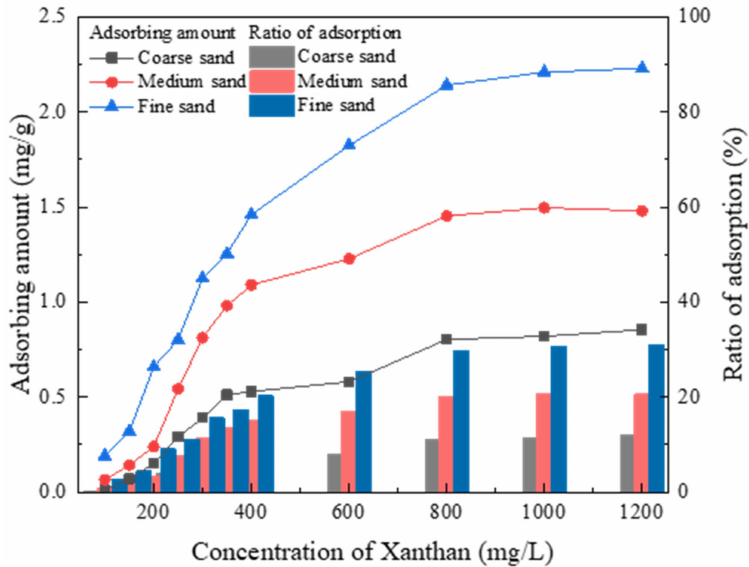
Figure 7. Static adsorption of xanthan gum in various